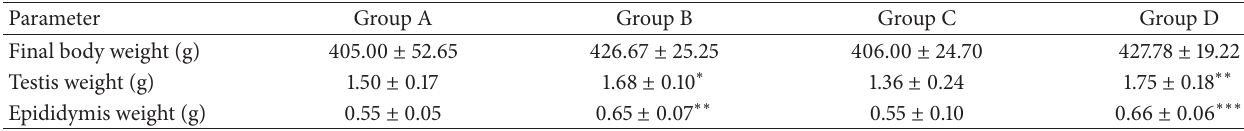
Table 1: Biometric parameters of control and experimental rat males.